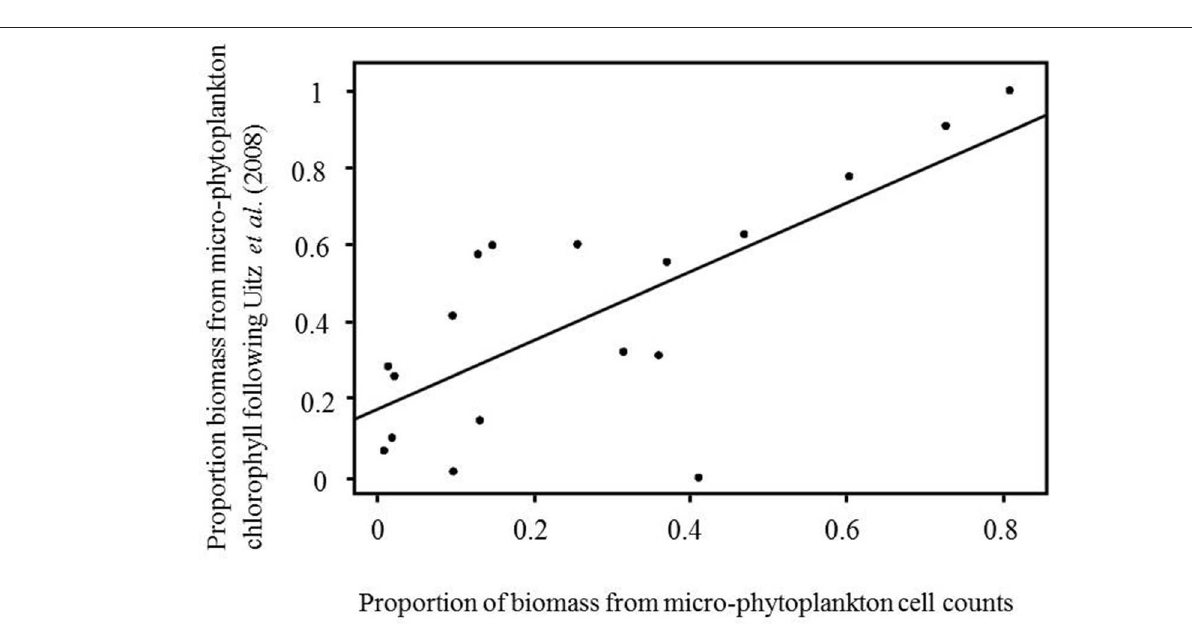
the Uitz et al. (2008) method serves as robust chemotaxonomic indicator of micro-phytoplankton